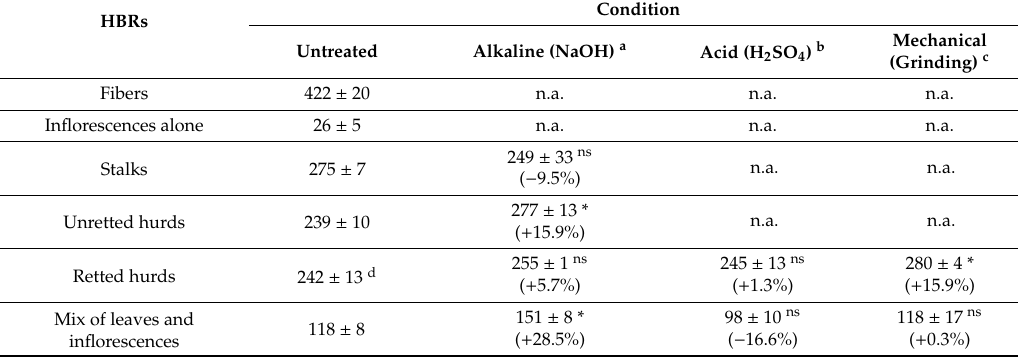
Table 2. Mean specific final cumulative biomethane production (mL CH 4 · g VS − 1 of HBRs added) measured through the BMP tests on the untreated and pretreated HBRs. Values are expressed as the mean and standard deviation calculated on three replicates. The percentage values within brackets represent the cumulative biomethane production surplus or deficit of pretreated substrates against that of the untreated ones. Condition HBRs Mechanical Untreated Alkaline (NaOH) a Acid (H 2 SO 4 ) b (Grinding)